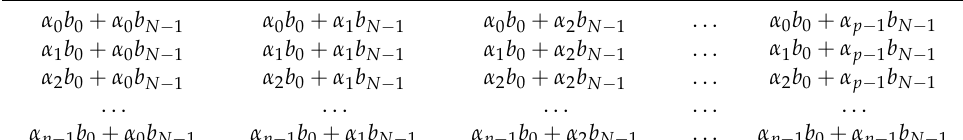
Table 3. Estimation of the elements number in the structures of modular and modified modular DF. Number of Elements of a Structural Scheme of a Type of a Digital Filter